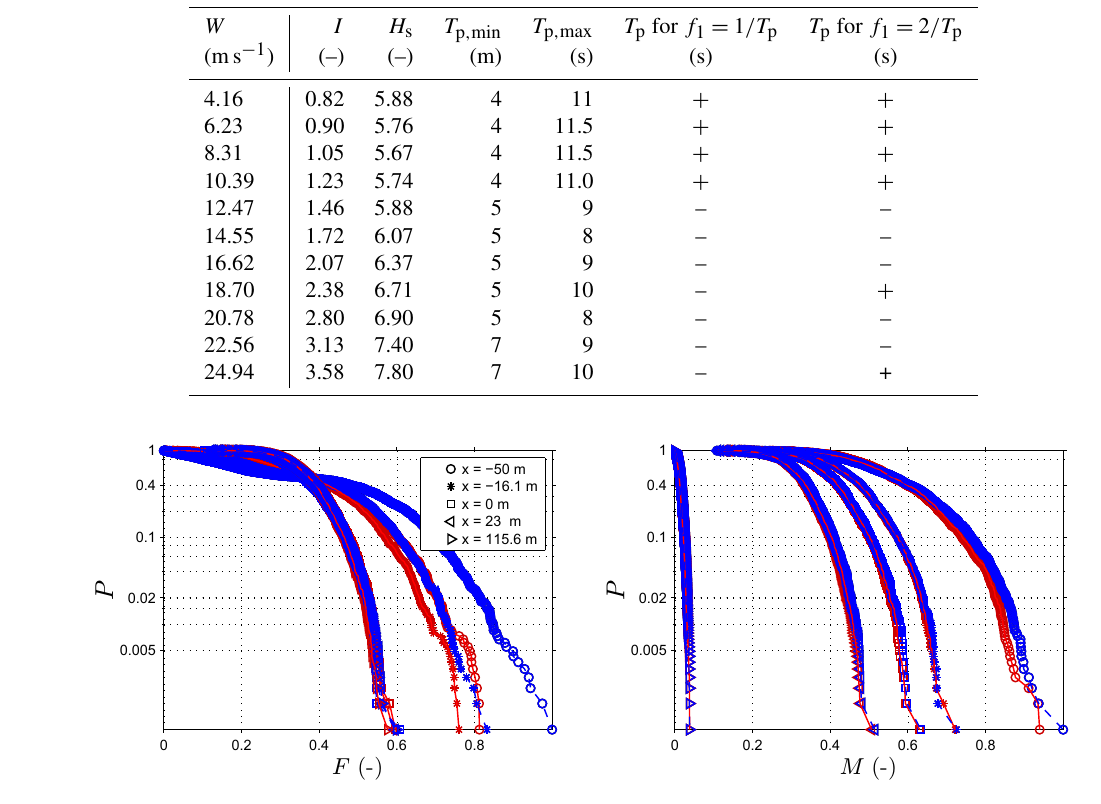
Figure 10. Probability of exceedance of the positive peaks in the time series of the sectional forces and moments for load case 1.2. Aerody- namic damping based on decay tests. The forces and moments are normalized with the largest force and moment peak at the seabed in the Flex5 calculation. Blue: Flex5. Red: